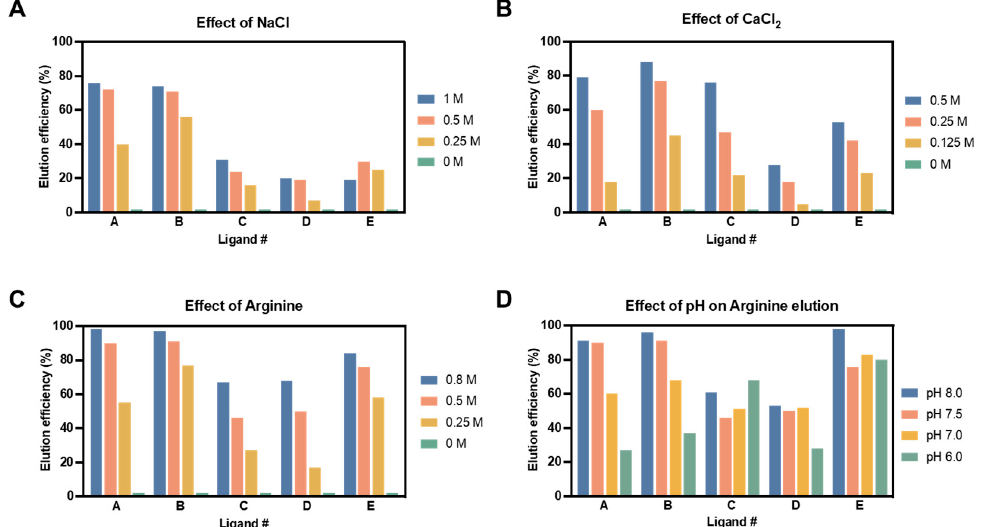
Figure 2. LVs release efficiency using biotin–ligand conjugates. Impact of different desorption buffers, sodium chloride ( A ), calcium chloride ( B ), and arginine ( C ), on elution efficiency (%) for the ligand candidates assessed by SPR assay. Three concentrations were included in the buffer elution optimization. ( D ) The influence of the elution pH on elution efficiency (%) was investigated using an intermediate arginine concentration, 0.5 M, at four pH values (8.0, 7.5, 7.0, and 6.0).